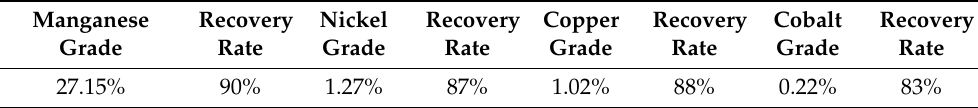
Table 3. Metal grade and smelting recovery rate in the CSU2019